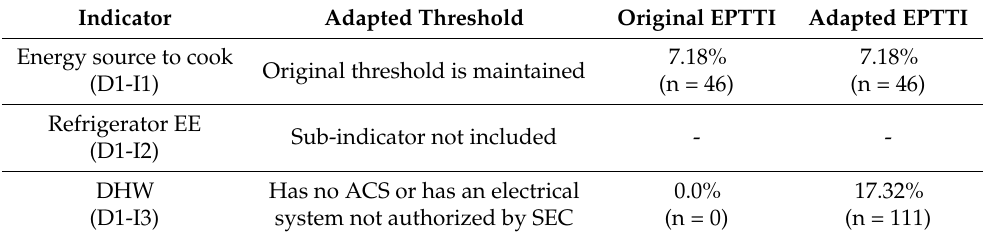
Table 5. Comparison of D1’s indicators for original and adapted